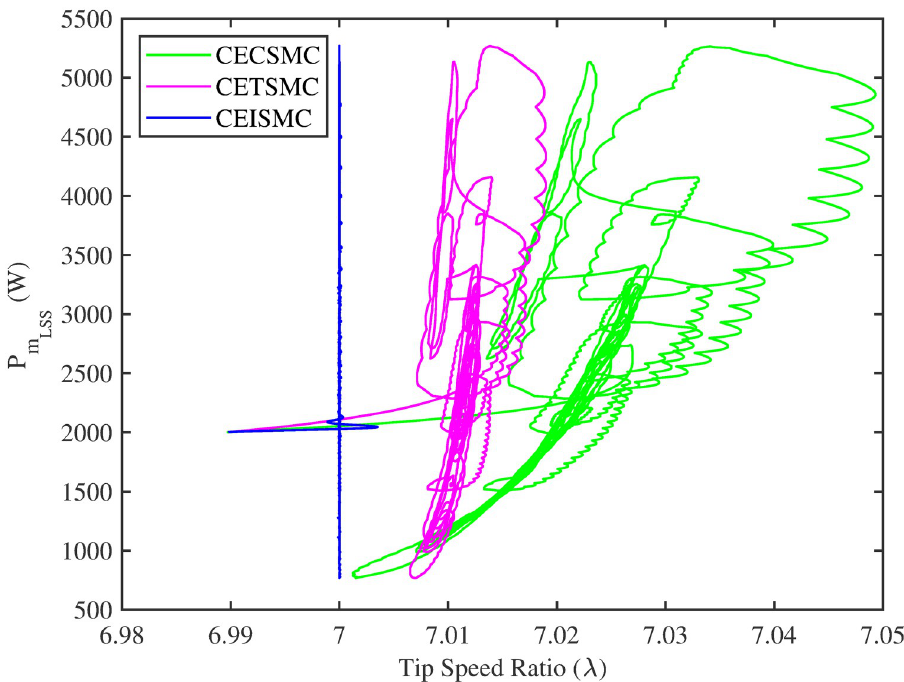
Fig 14. Tip speed ratio versus low speed shaft